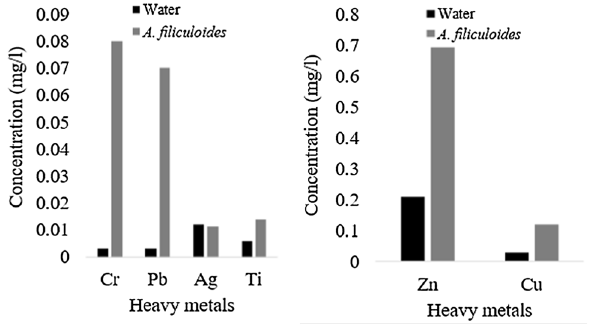
Fig. 3 Concentration of heavy elements in the samples of water and A. filiculoides in the central part of the